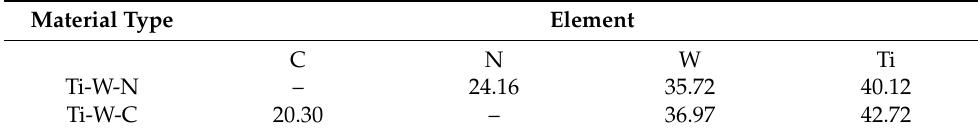
Table 2. Chemical composition in atomic concentration (%) using XPS.